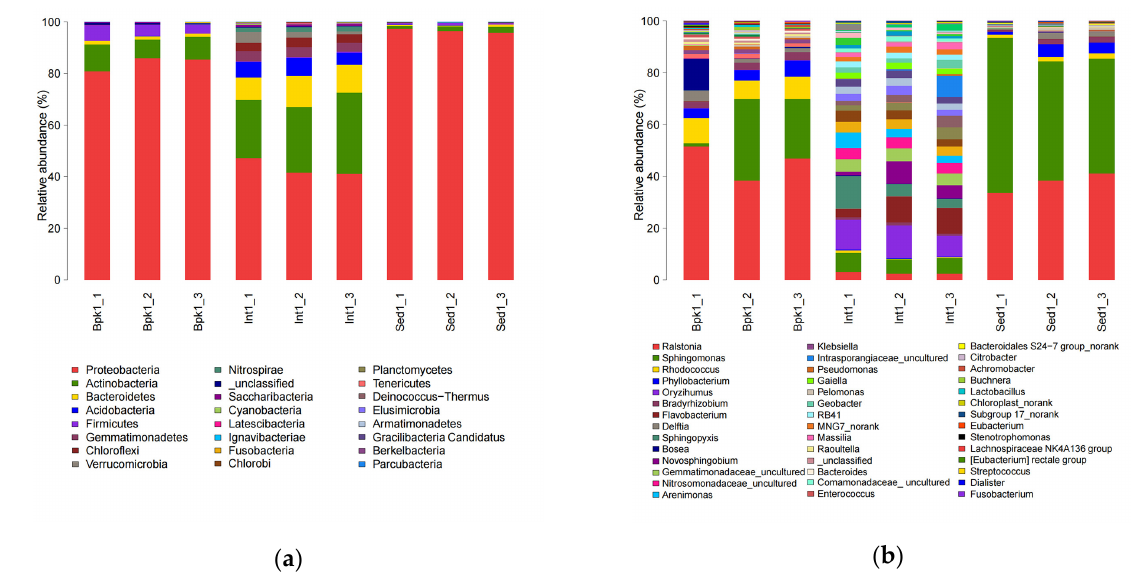
Figure 2. Bar charts of relative species abundance of bacteria at the phylum level ( a ) and genus level ( b ).